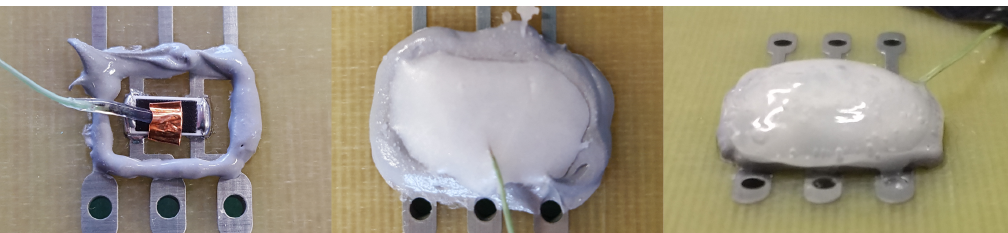
Figure 7. Dam and Fill example on a 2512 chip resistor. Left —mounted resistor with single dam structure, Middle —added PCM, Right —with applied PCM and Glob Top capping.